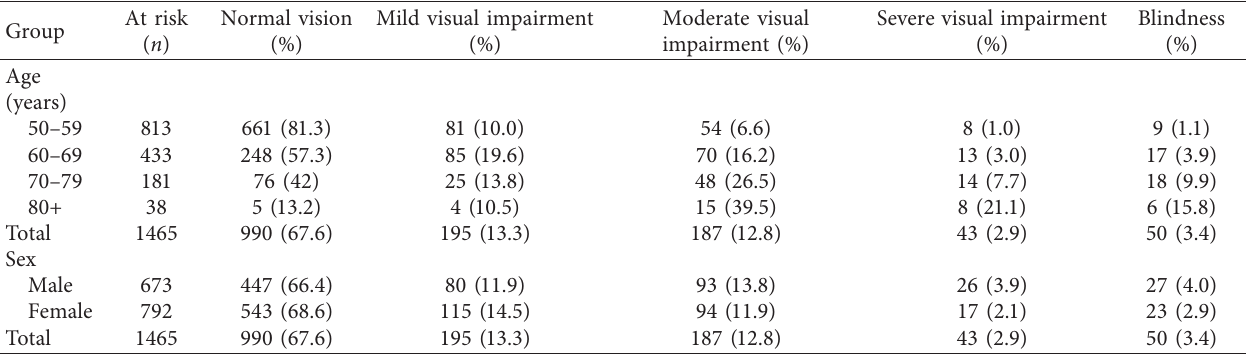
Table 2: Age-specific and gender-specific prevalence of visual impairment.